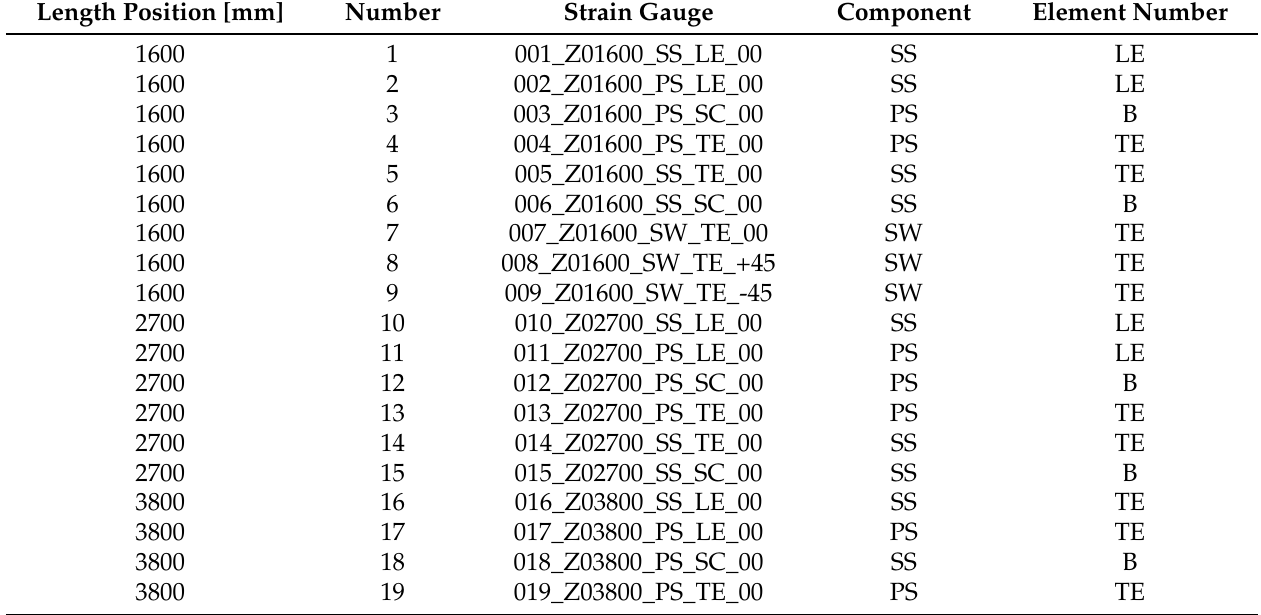
Table A1. List of strain gauges at components (PS—pressure side, SS—suction side, SW—shear web) and position (LE—leading edge, TE—trailing edge,